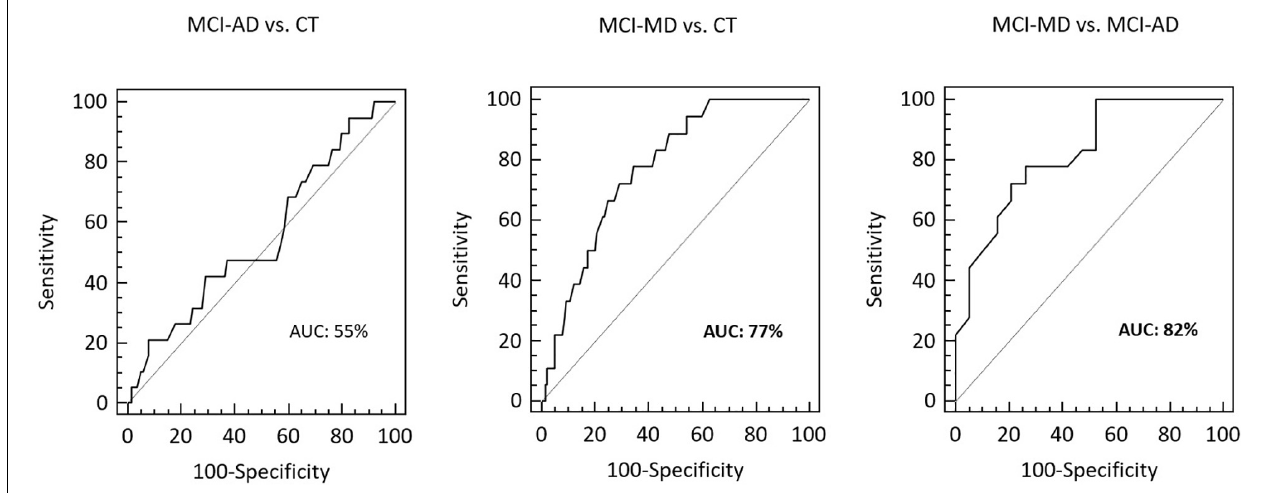
FIGURE 3 | The ROCs curve of VAMP2 gene expression for MCI-AD vs. CT, MCI-MD vs. CT and MCI-MD vs. MCI-AD evaluation. ROC, receiver operating characteristic; AUC, area under the curve.